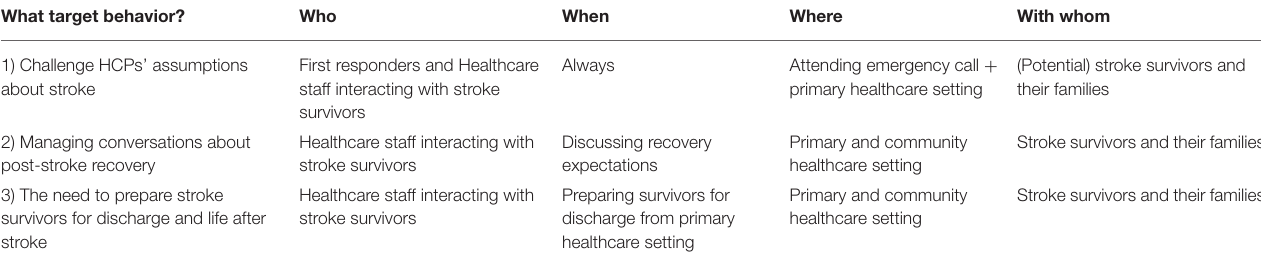
TABLE 5 | Specifying target behaviors (BCW step